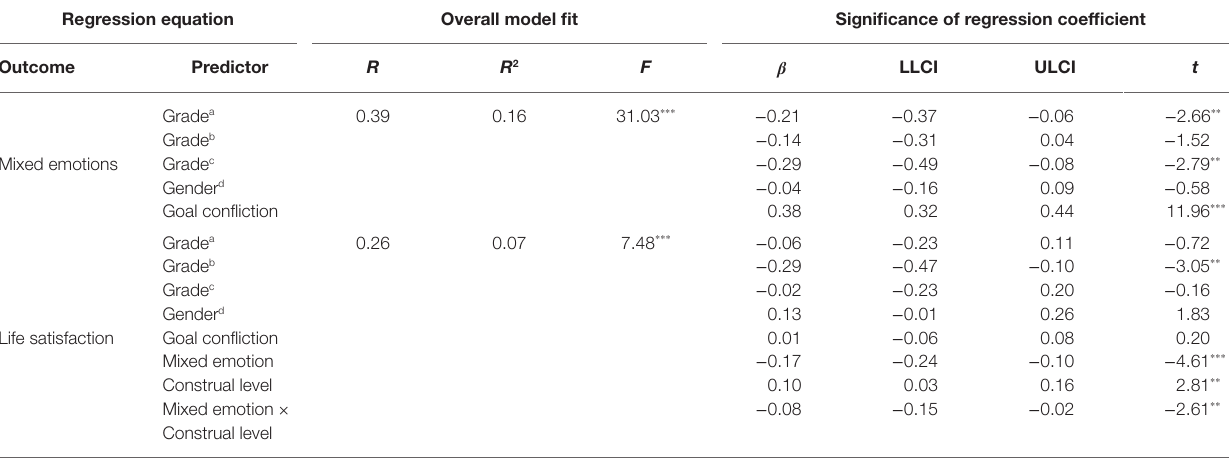
TABLE 3 | Regression analysis results of construal level moderate the mediation process. Regression